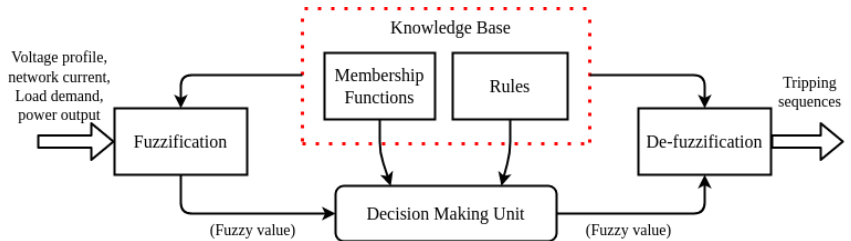
Figure 5. Proposed fuzzy inference system for effective energy management strategies in utility